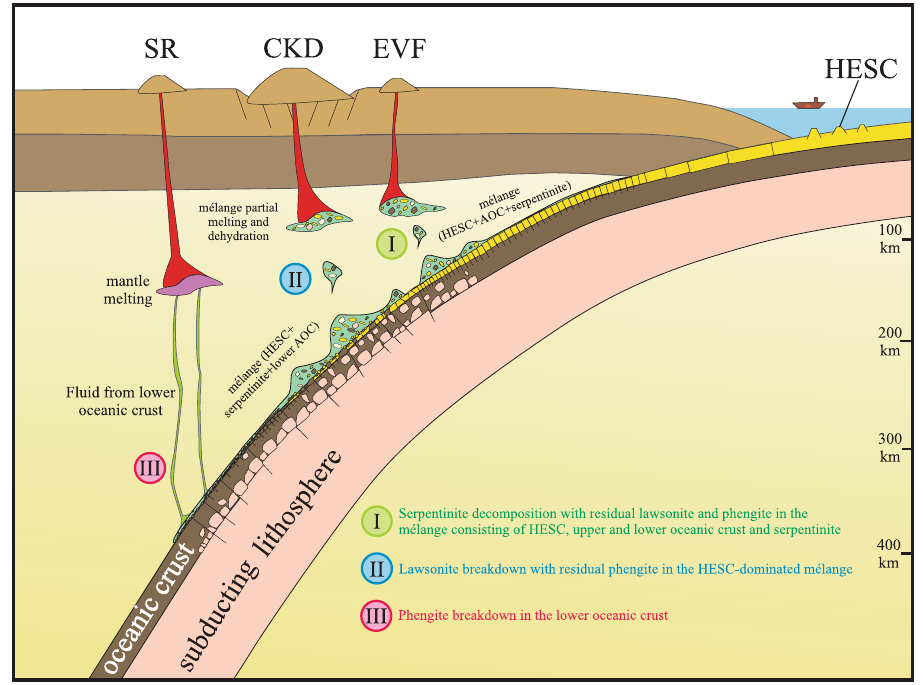
Fig.8|CartoonofthemélangemodelofslabmaterialtransportinKamchatka subduction zone. (I) Below Eastern Volcanic Front (EVF), the mélange contains Hawaii-Emperor Seamount Chain (HESC), upper and lower oceanic crust and ser- pentinite.Decompositionofserpentinewithresiduallawsoniteandphengiteinthe mélange account for the highest fl uid-mobile chalcophile trace element con- centrationsand δ 11 BvaluesaswellasCs/U,Cs/PbandB/Nb,togetherwithrelatively high Cs/Tl and U/K and low Sr/Nd and Ba/Th. (II) Underlying Central Kamchatka